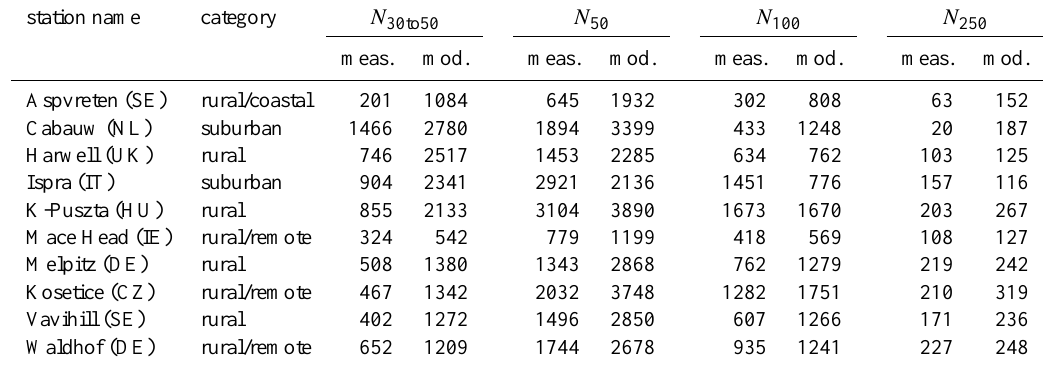
Table 4. Comparison of number concentration comparisons, like in Table 3, but for the spring 2009